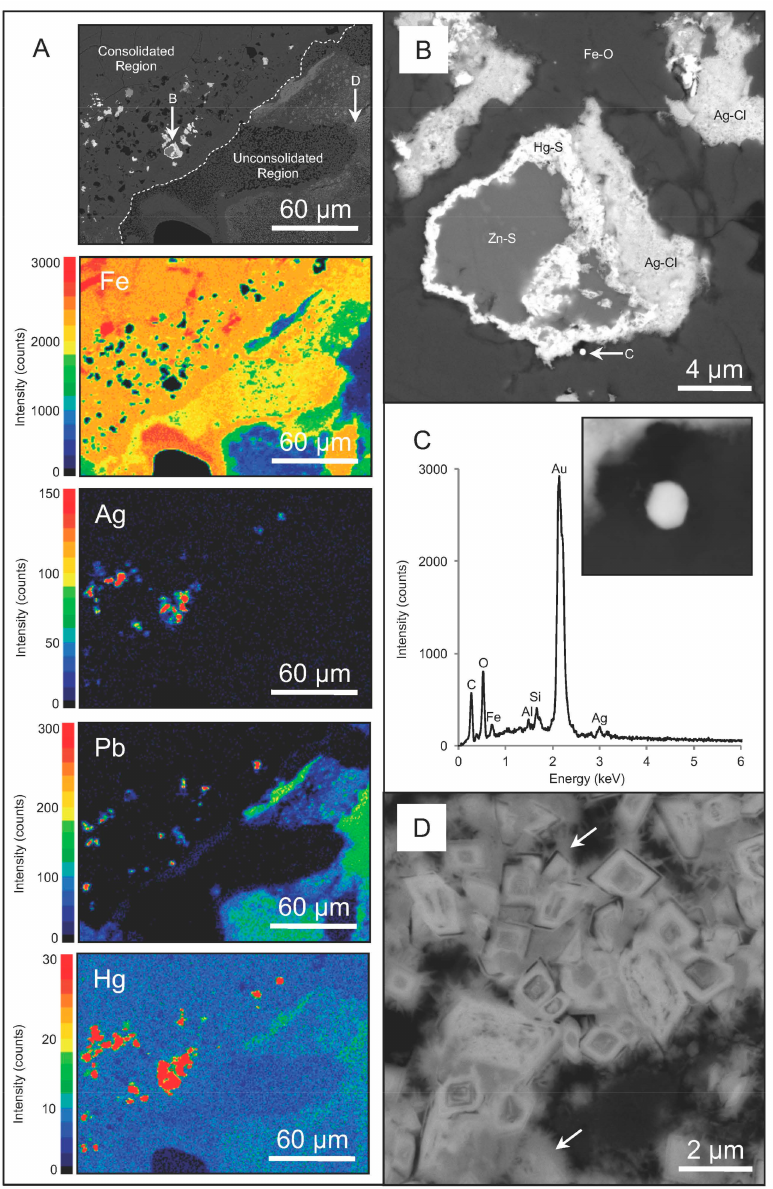
Figure 2. A low-resolution BSC SEM micrograph demonstrating the consolidated and unconsolidated region within gossan and corresponding EMP maps highlighting the distribution of Ag, Fe, Pb and Hg. Silver occurred in close association with mercury ( A ); a high-resolution BSC SEM micrographs of a secondary Ag-bearing minerals and a secondary, gold nanoparticle within the consolidated regions ( B , C ). A high-resolution BSC SEM micrograph of euhedral plumbojarosite coated with acicular; iron-oxidehydroxide minerals (arrows, D